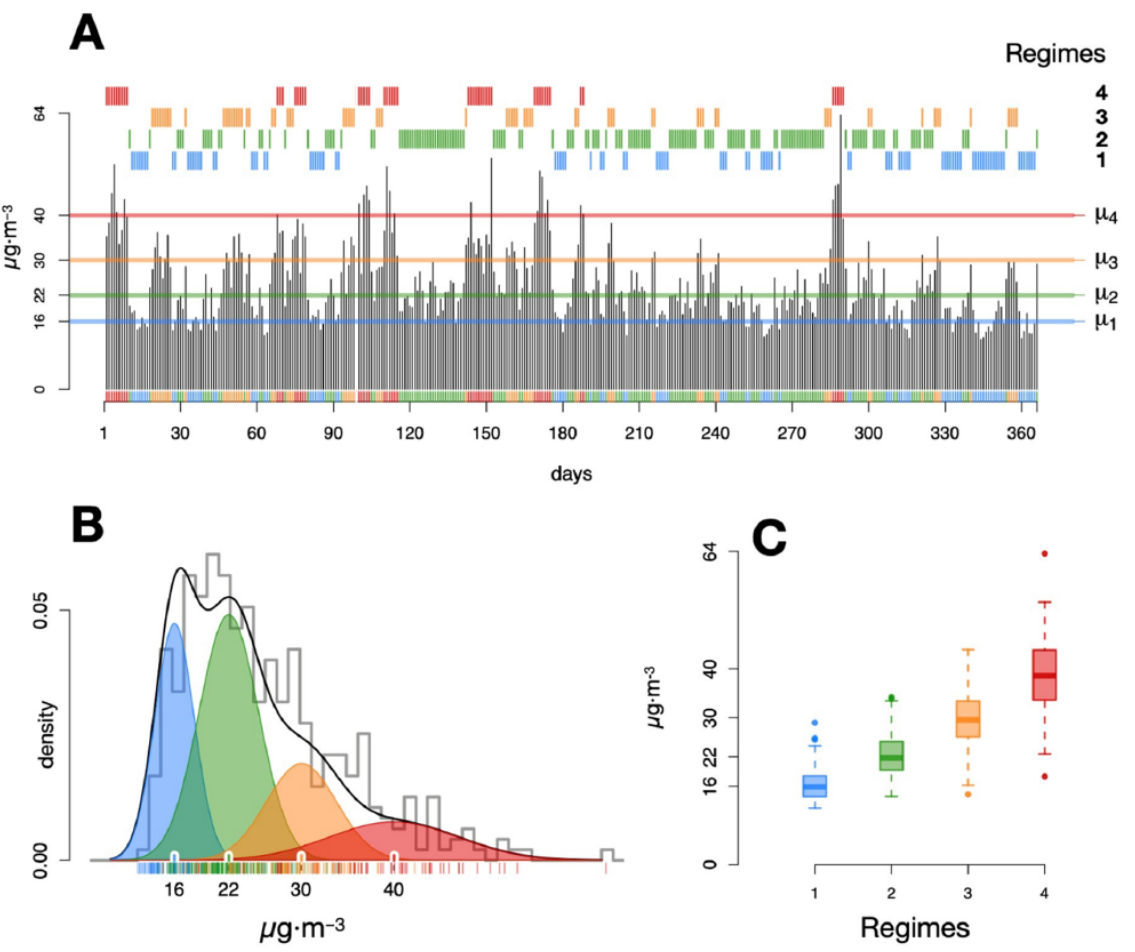
Figure 1. Time series (TS) clustering method showing the four pollution profiles (regimes) detected in the PM 10 TS from the ES1517 Spanish station (2017). First to fourth pollution regimes are represented in blue, green, orange, and red, respectively. ( A ) TS observations (grey). Below TS, each observation is associated with a cluster. Separately, this grouping is represented above the TS. Horizontal lines represent the average values of each cluster ( µ 1 , µ 2 , µ 3 , µ 4 ). ( B ) The estimated density of the mixture of distributions (black line) is superimposed onto the histogram of TS data (grey line). Components of the mixture are represented for each cluster (coloured shadows). ( C ) Distribution of values of each TS pollution profile is represented as box-whisker plots.